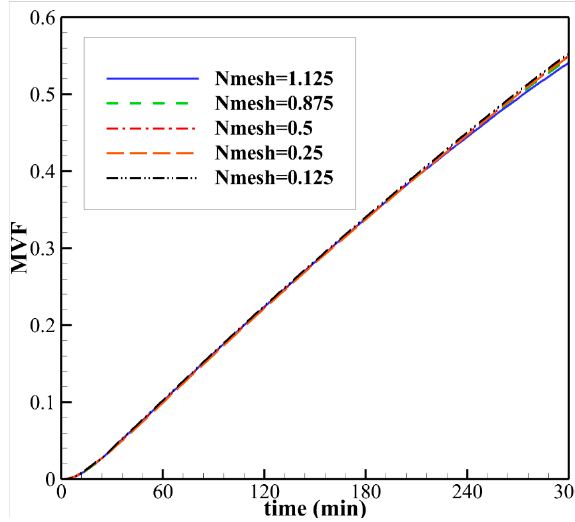
Figure 3. A view of utilized mesh for case Nmesh = 0.25. ( a ) An overall mesh view, ( b ) mesh de- tails over the fins and PCM domain, ( c ) mesh details at the tube wall and metal foam layer, and ( d ) Figure 2. Mesh sensitivity data for various element sizes. Figure 2. Mesh sensitivity data for various element sizes. the mesh details at the fin edge and PCM domain outer wall.